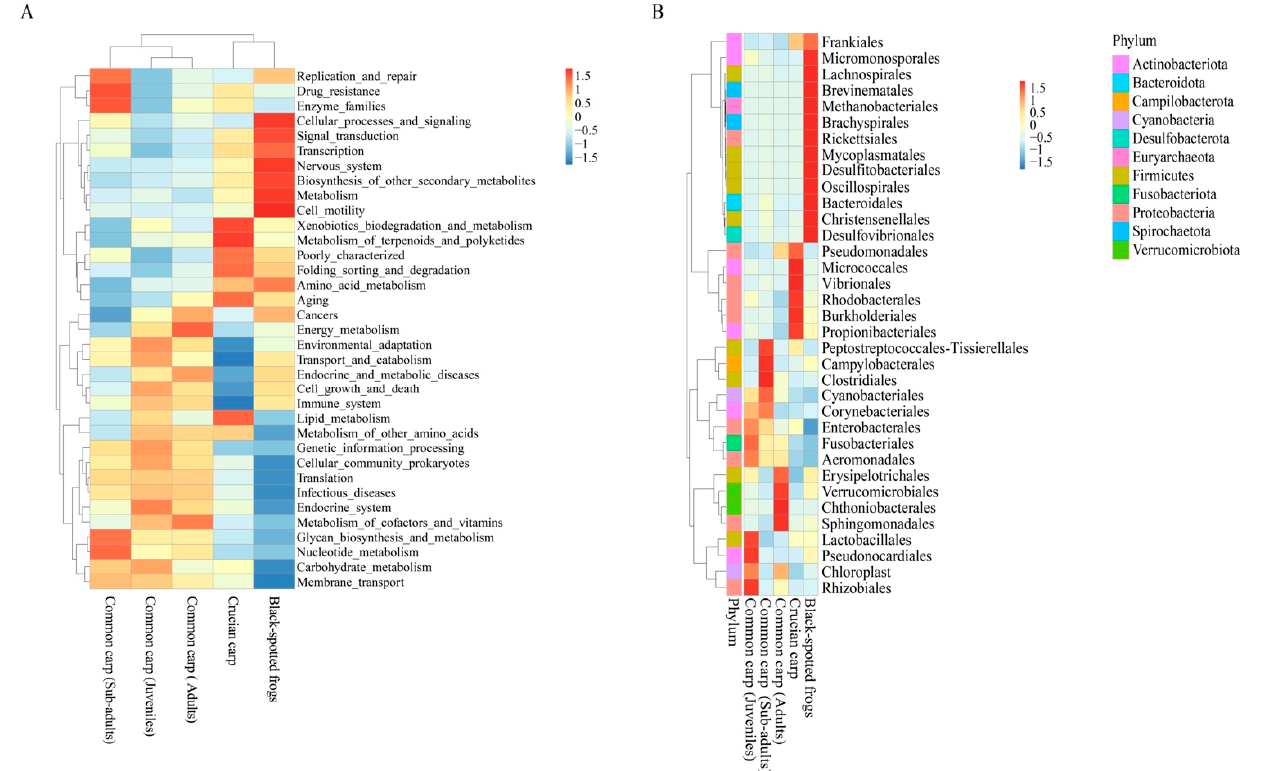
Figure 5. Heat map of the relative abundance of the top 35 Level II Kyoto Encyclopedia of Genes and Genomes (KEGG) pathway categories ( A ) and top 35 bacterial families ( B ) during three developmental stages in common carp and crucian carp and black-spotted frogs showing significant differences.